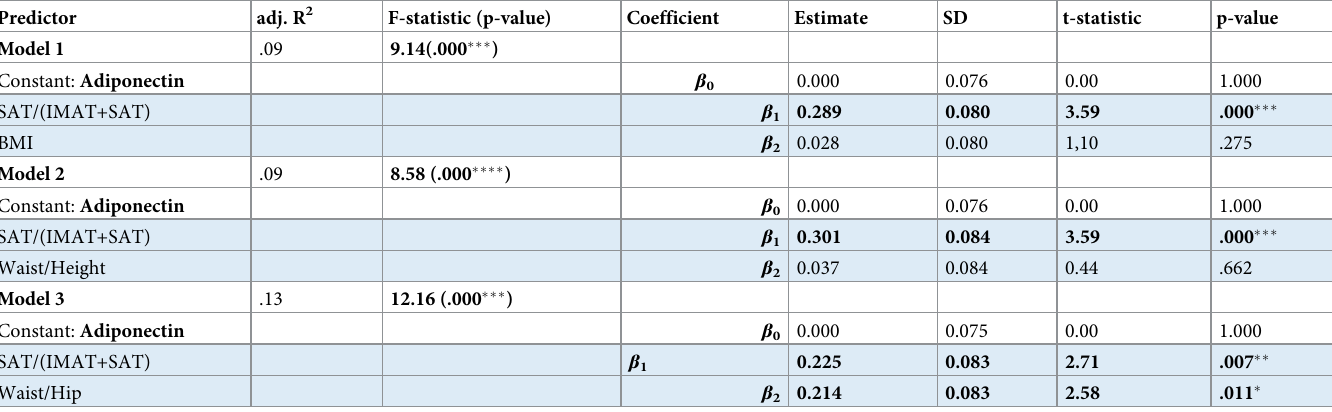
Table 4. Effect of anthropometric parameters on the correlation between adiponectin and SAT/(IMAT+SAT). Predictor adj. R